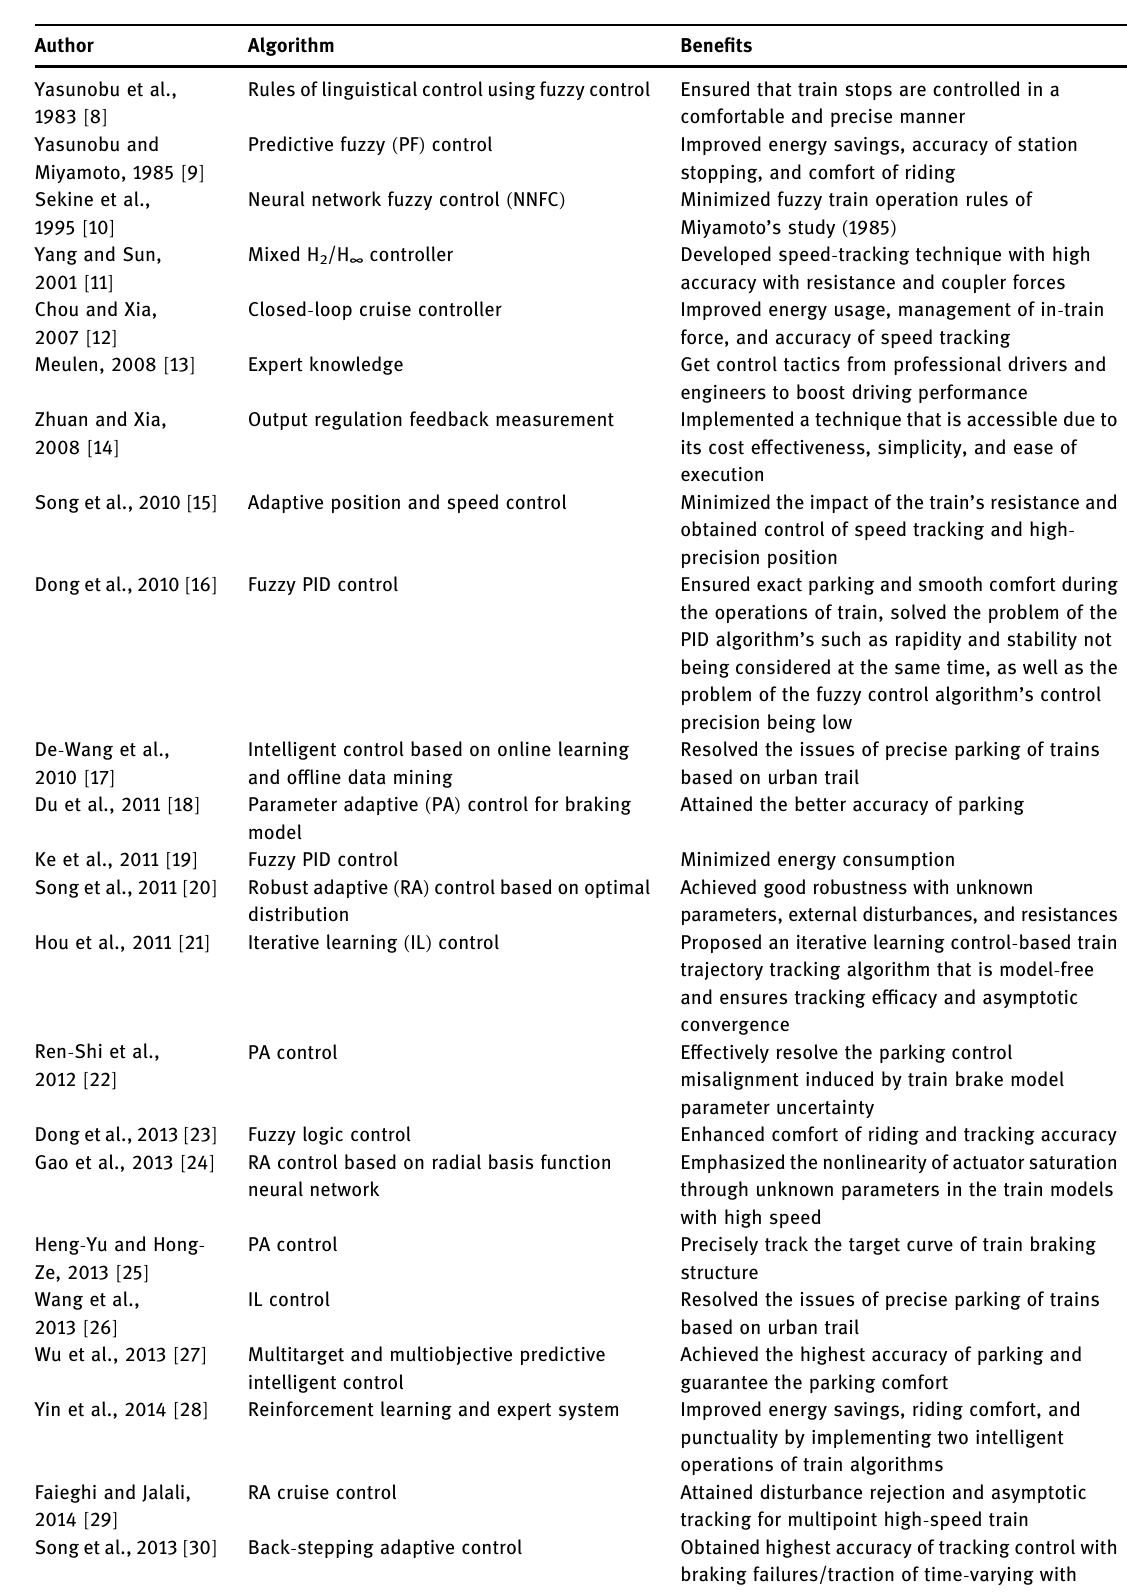
Table 1: Literature review on ATO control